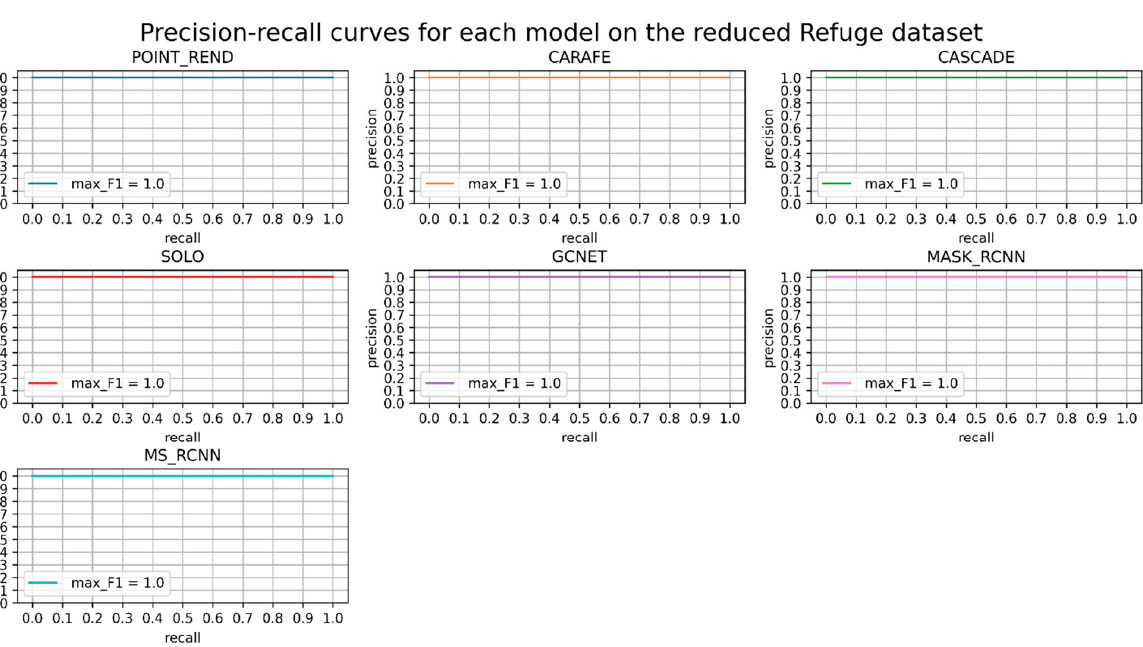
12 of 20 Table 4. Average precision results on G1020 dataset.